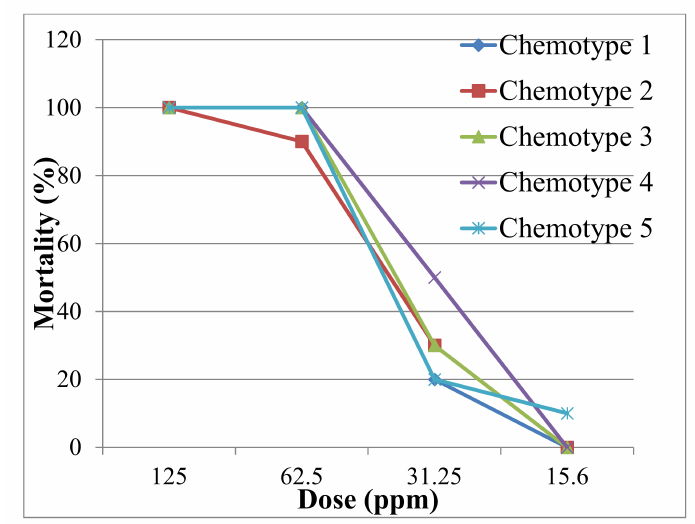
Figure 2. Toxicity of essential oils from di ff erent chemotypes of S. pilosa against 1-d old larvae of Aedes